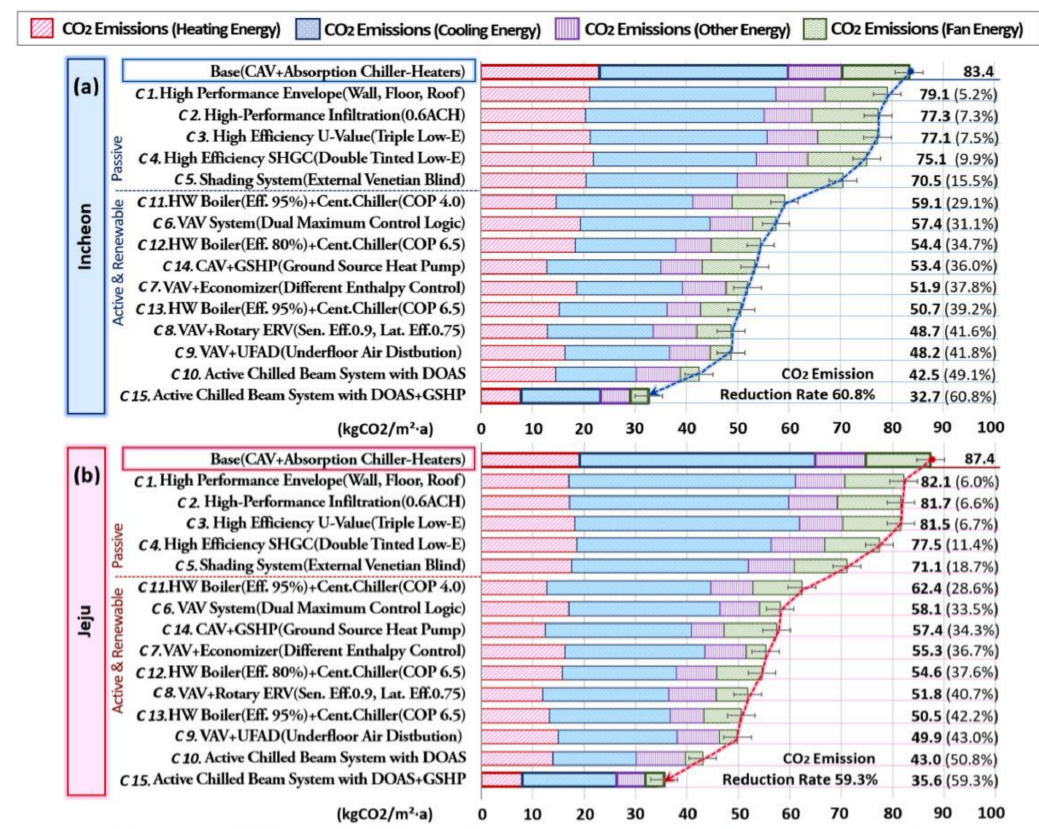
Figure 20. CO 2 emissions and reduction potential (%) of each technology in ( a ) Incheon and ( b )